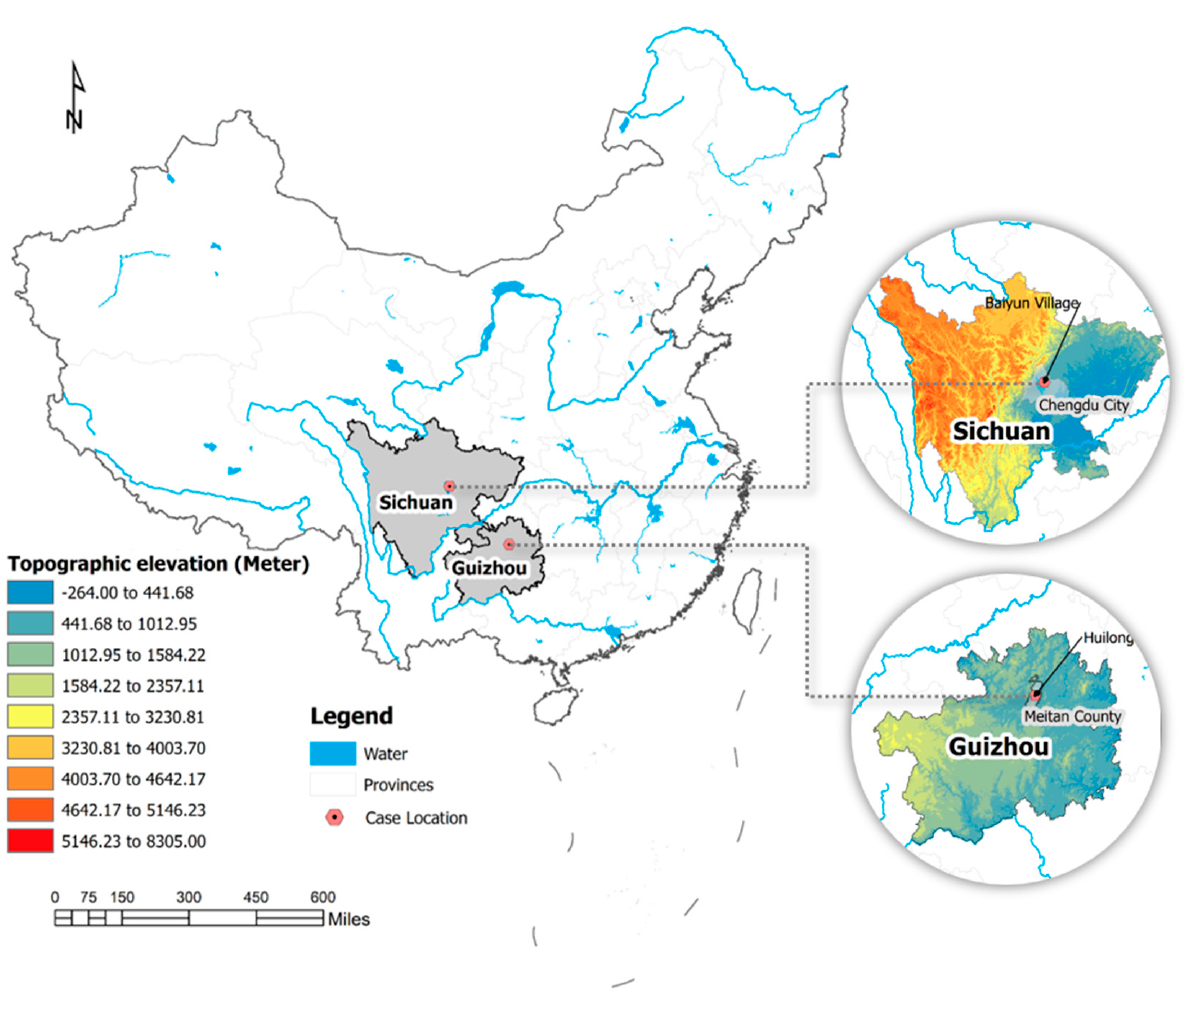
Figure 2. The locations of the two case study areas.